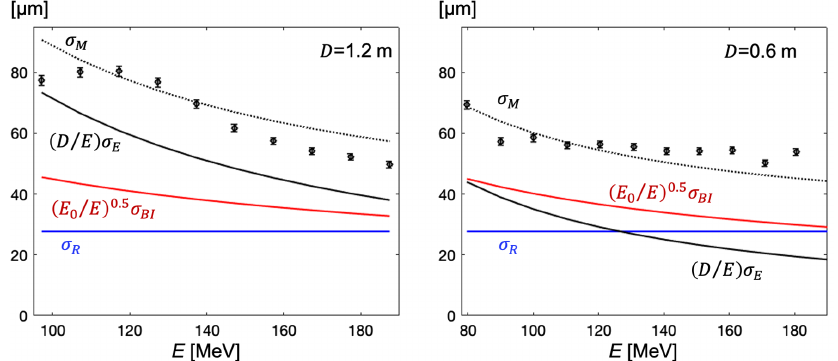
FIG. 15. Comparison of the measurements of the energy scan (dots with error bars) with the values calculated from the data of the dispersion